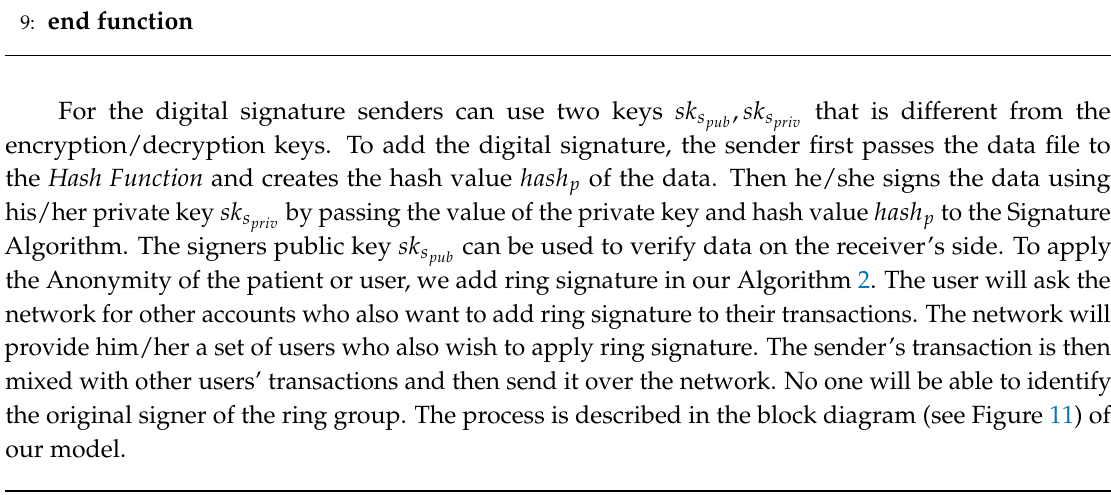
Algorithm 2 Ring Signature and Public Key